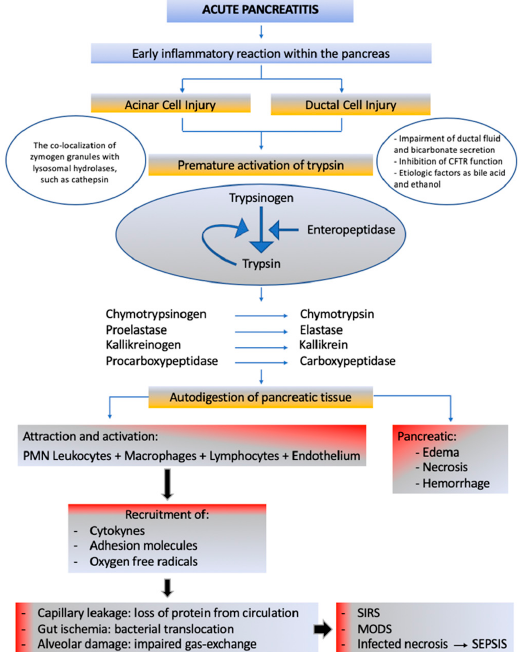
Figure 1. A schematic overview of acute pancreatitis’s pathogenesis. The premature activation of trypsin caused by acinar and ductal cell injury. Attraction and activation of leukocyte,